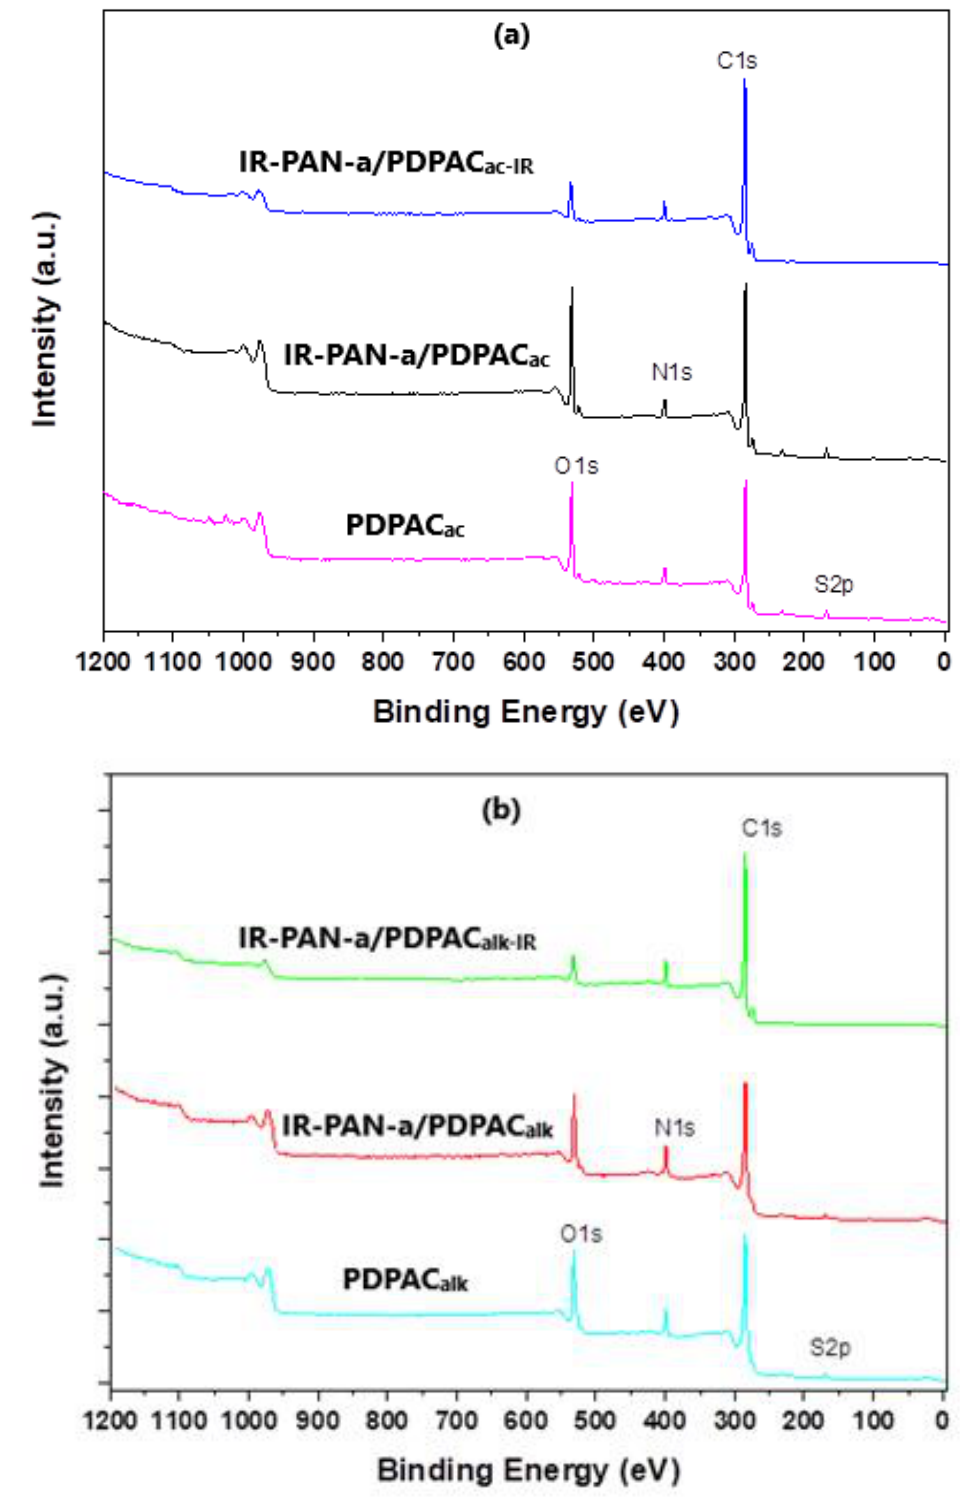
Figure 6. XPS survey spectra of PDPAC, IR-PAN-a/PDPAC, and IR-PAN-a/PDPAC IR prepared in an acidic ( a ) and an alkaline medium ( b ).